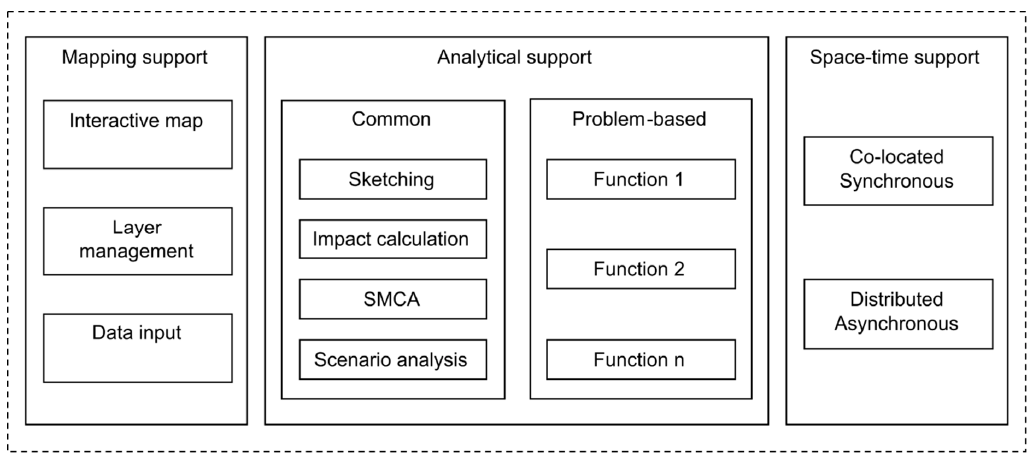
Figure 4. Central components of an interactive PSS tool for a map table.